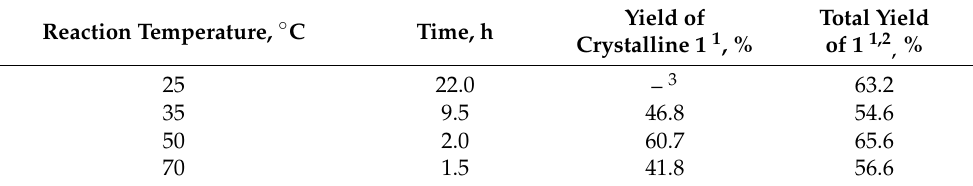
Table 2. Temperature effect on reaction time and yield of 1 in t -butanol.